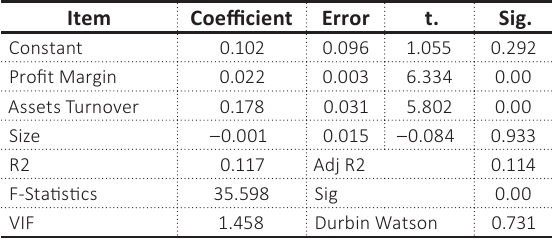
Table 6. Results for the second model